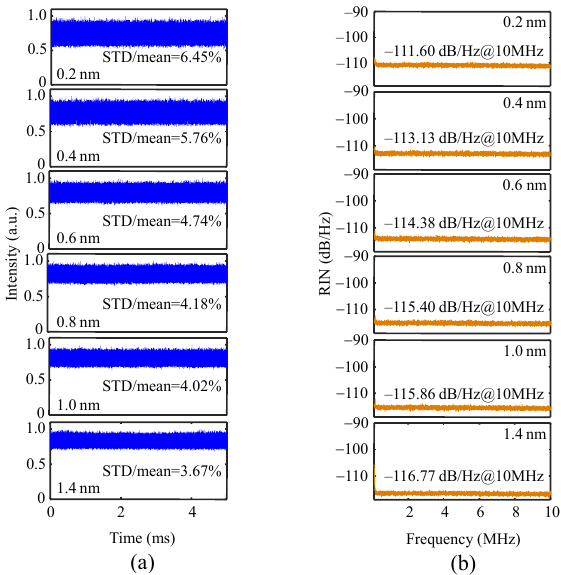
Fig. 3 Temporal properties of the YRFL seeds with different point reflector’s bandwidths: (a) time domain traces and (b) RINs.